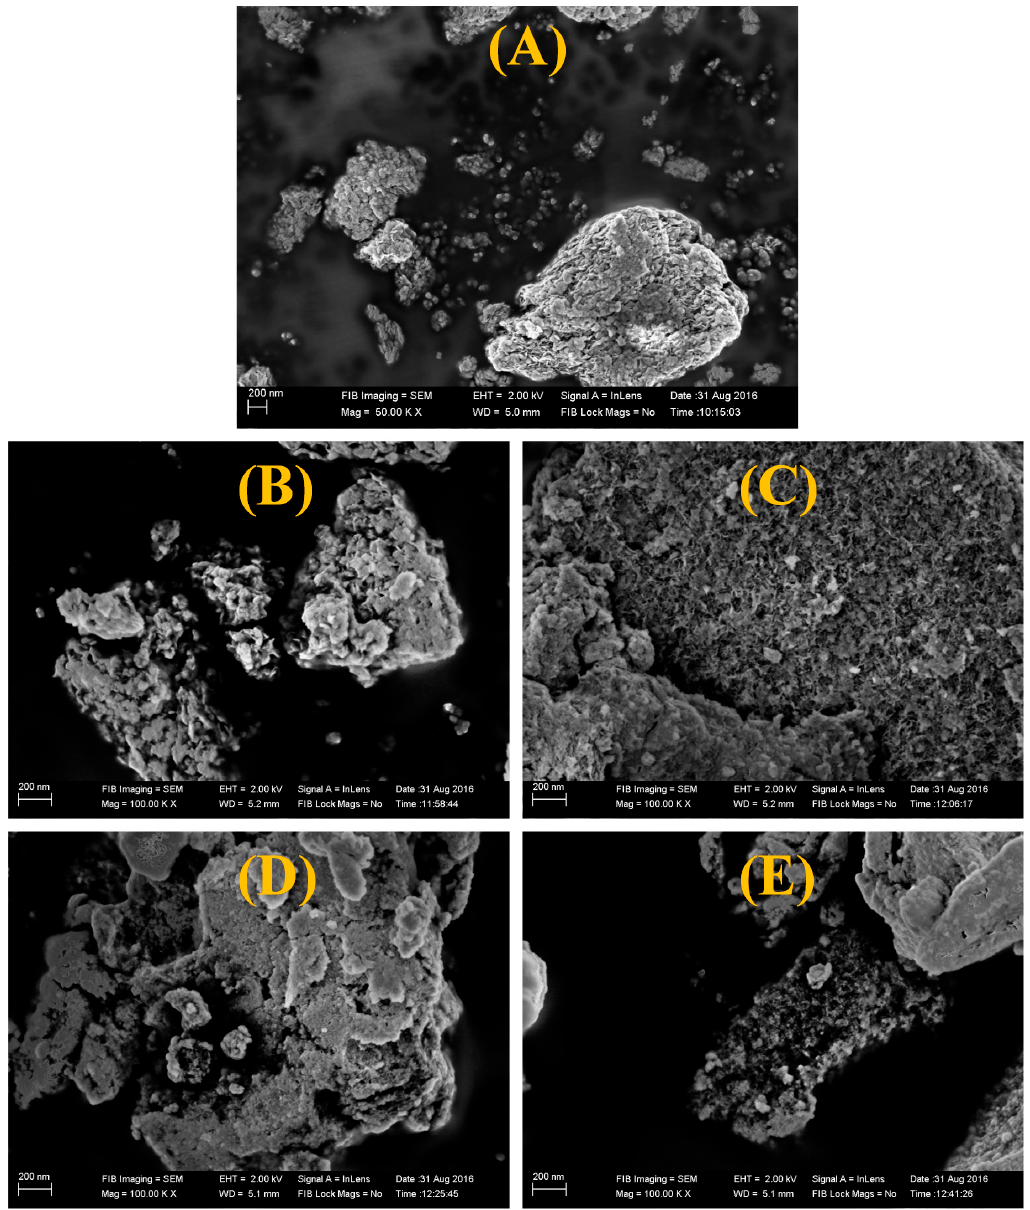
Figure 4. SEM images of ( A ) pristine NiO, ( B ) pristine NiO with PEG, ( C ) NiO with PEG and 1 wt% Li, ( D ) NiO with PEG and 2 wt% Li, ( E ) NiO with PEG and 5 wt% Li. ( D ) NiO with PEG and 2 wt% Li, ( E ) NiO with PEG and 5 wt%